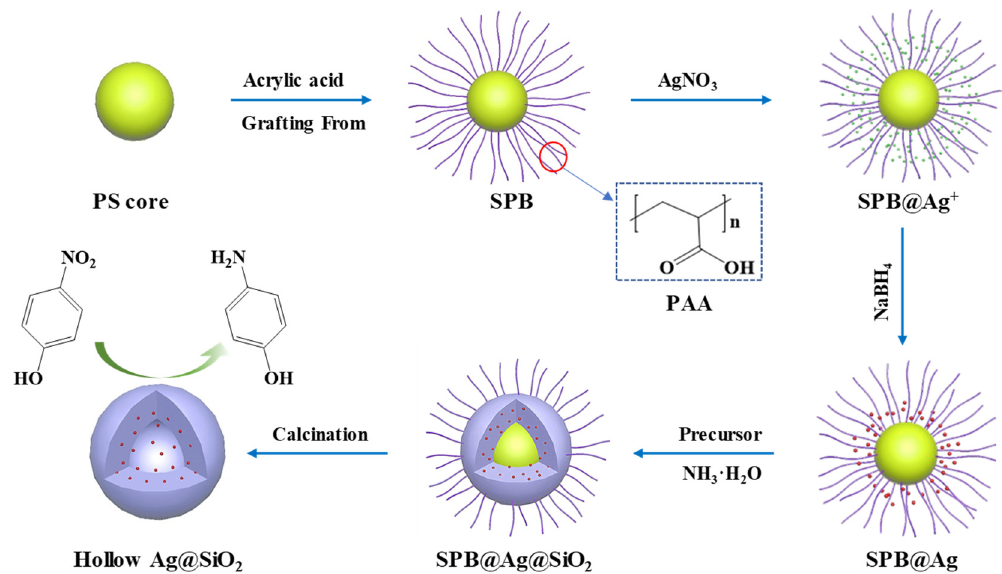
Figure 1. Schematic representation of preparation and catalytic application of hollow silica spheres with encapsulated silver nanoparticles (Ag@SiO 2 ) based on SPB.